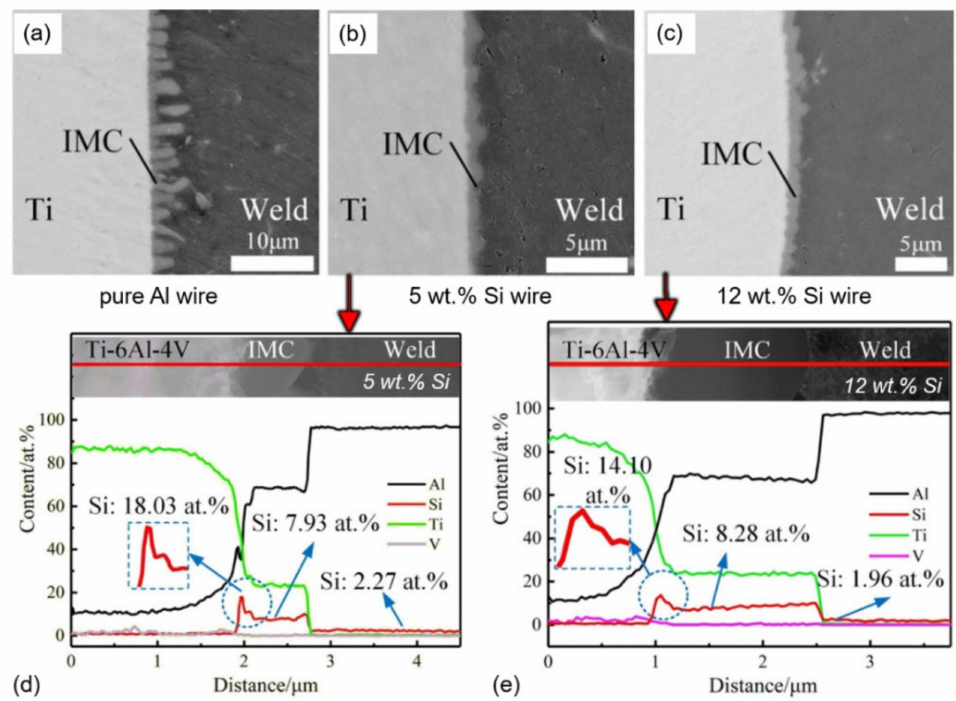
Figure 26. Effect of filler wire composition of IMC layer structure: ( a ) pure Al wire; ( b ) 5 wt.% Si wire; ( c ) 12 wt.% Si wire; ( d ) EDS results for 5 wt.% Si wire; and ( e ) EDS results for 12 wt.% Si wire. From